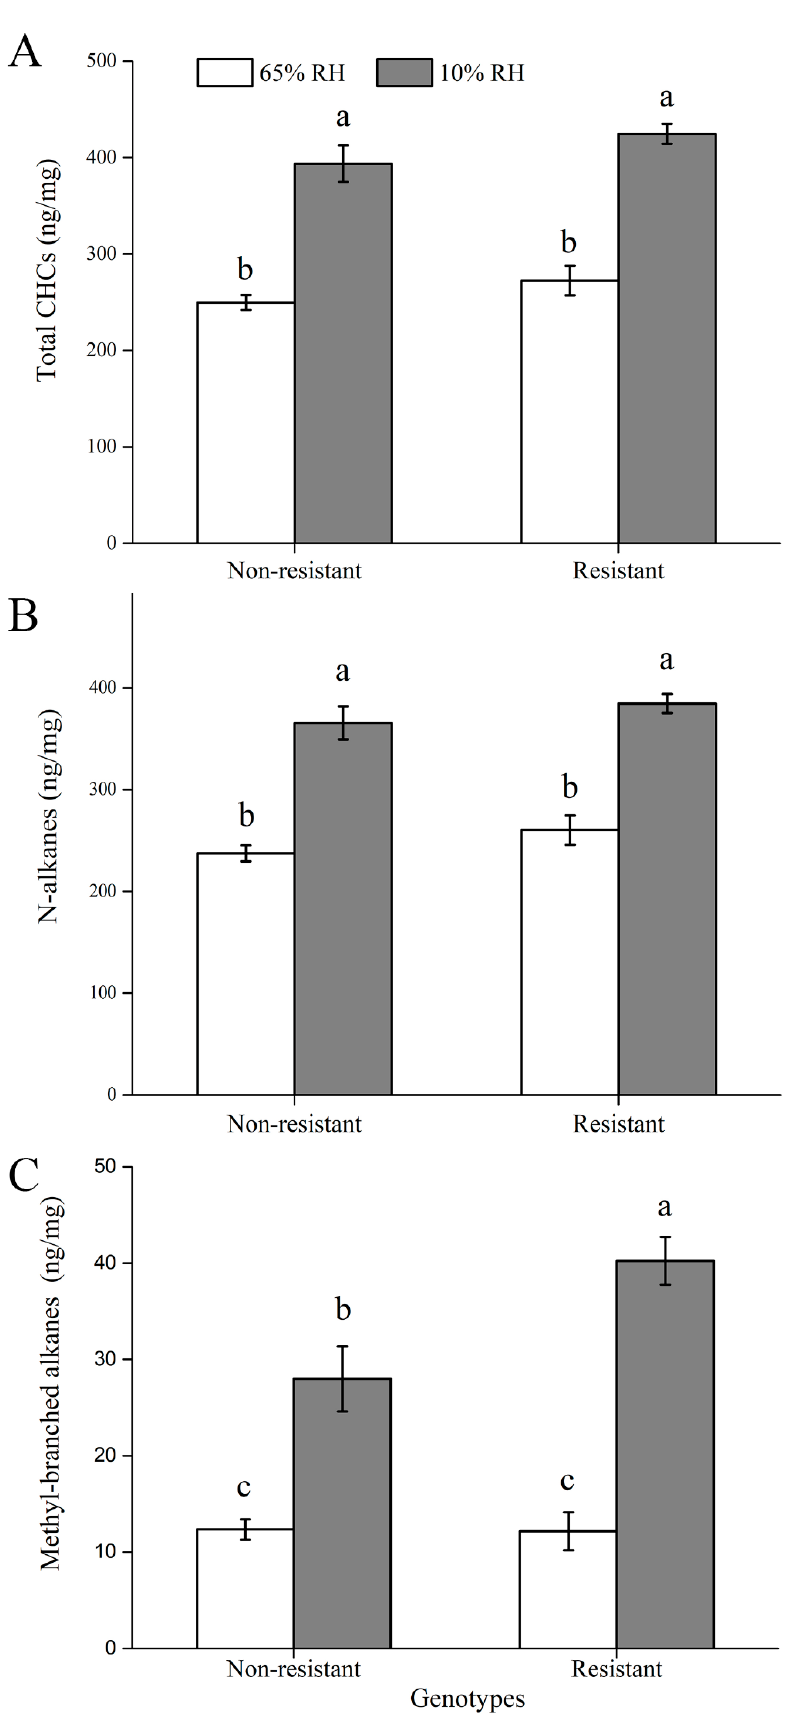
Figure 5. Comparisons of cuticular hydrocarbon (CHC) contents for wingless Sitobion avenae under 10% and 65% RH (relative humidity): ( A ) total CHCs; ( B ) n -alkanes; ( C ) methyl-branched alkanes. Di ff erent letters above bars indicate significant di ff erences between